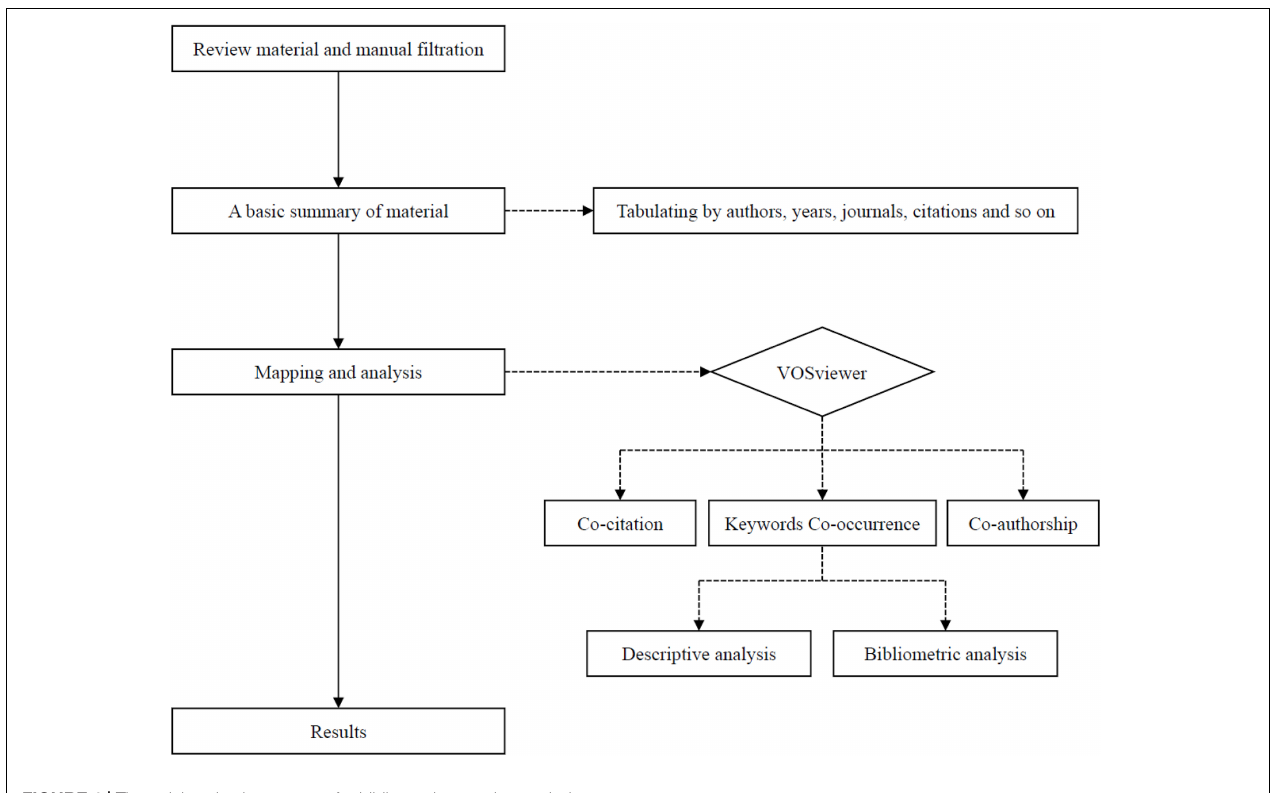
FIGURE 1 | The article selection process for bibliometric mapping analysis.